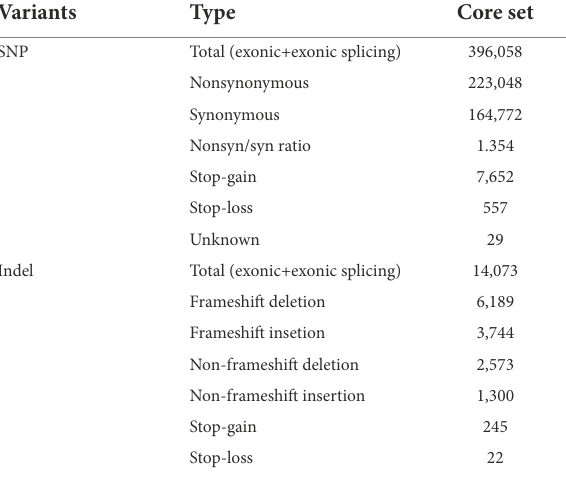
TABLE 2 The number of SNPs and indels in different genome structures.